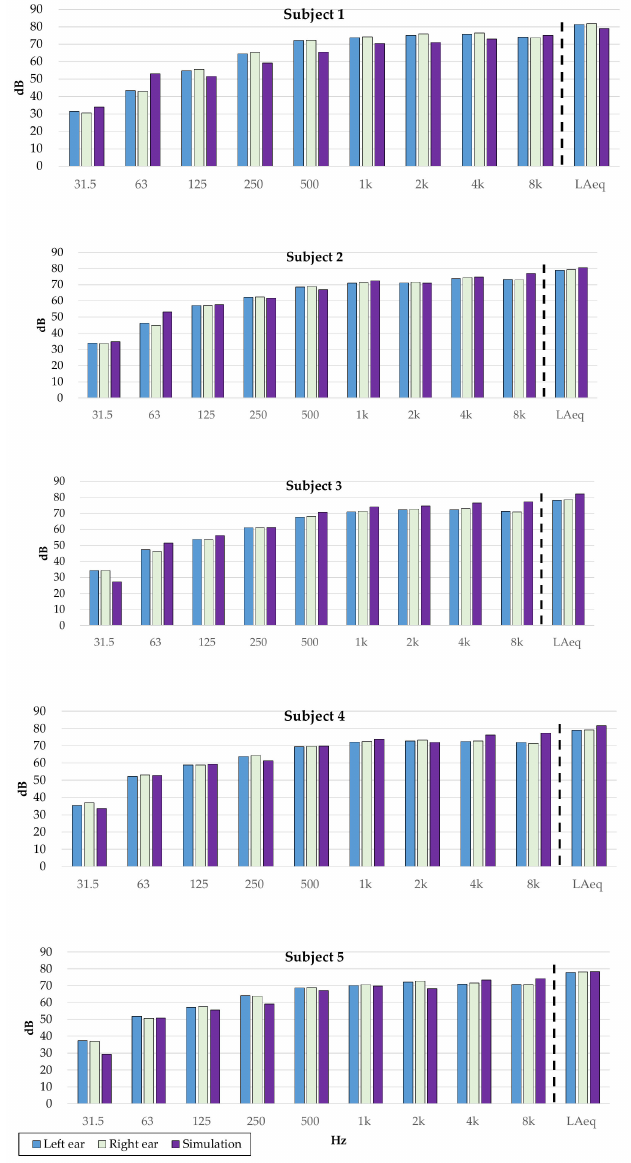
Figure 2. Frequency spectra and equivalent continuous noise levels (LA eq s) of personal measurements and simulation